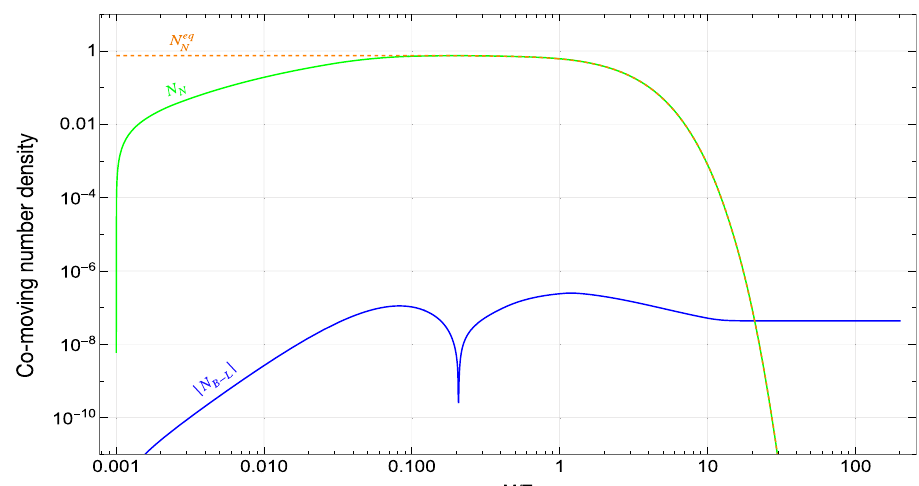
Fig. 4 Evolution of the B − L symmetry in the hierarchical scenario. The color code is the same as in Fig.